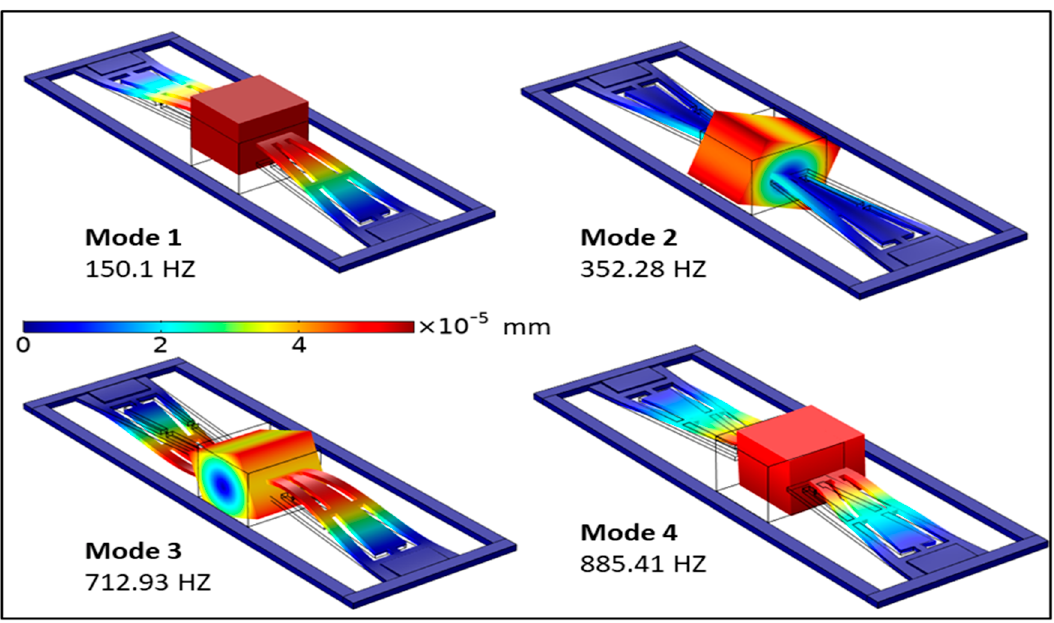
Figure 2. FEM analysis of the exsect spring structure design depicting the first four modes of the nonlinear PEH. The color legend shows the deformation of the structure in the z -axis. Table 1. Material properties and parameters of the nonlinear